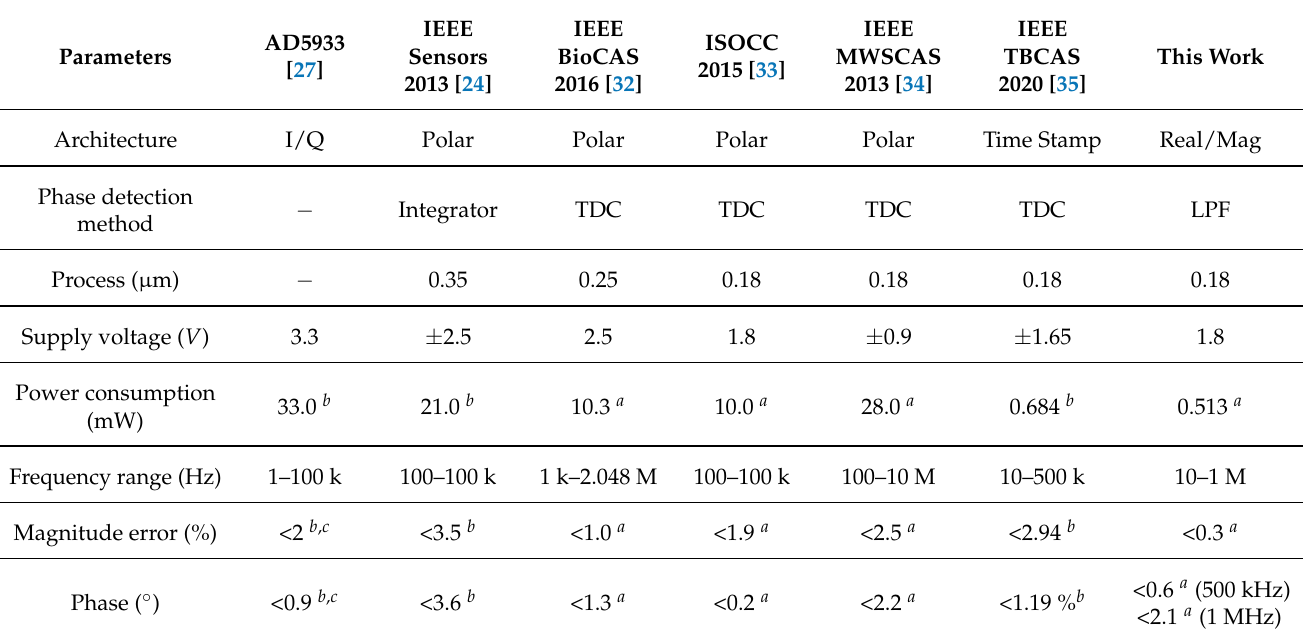
Table 1. Performance summary and comparison with state-of-the-art